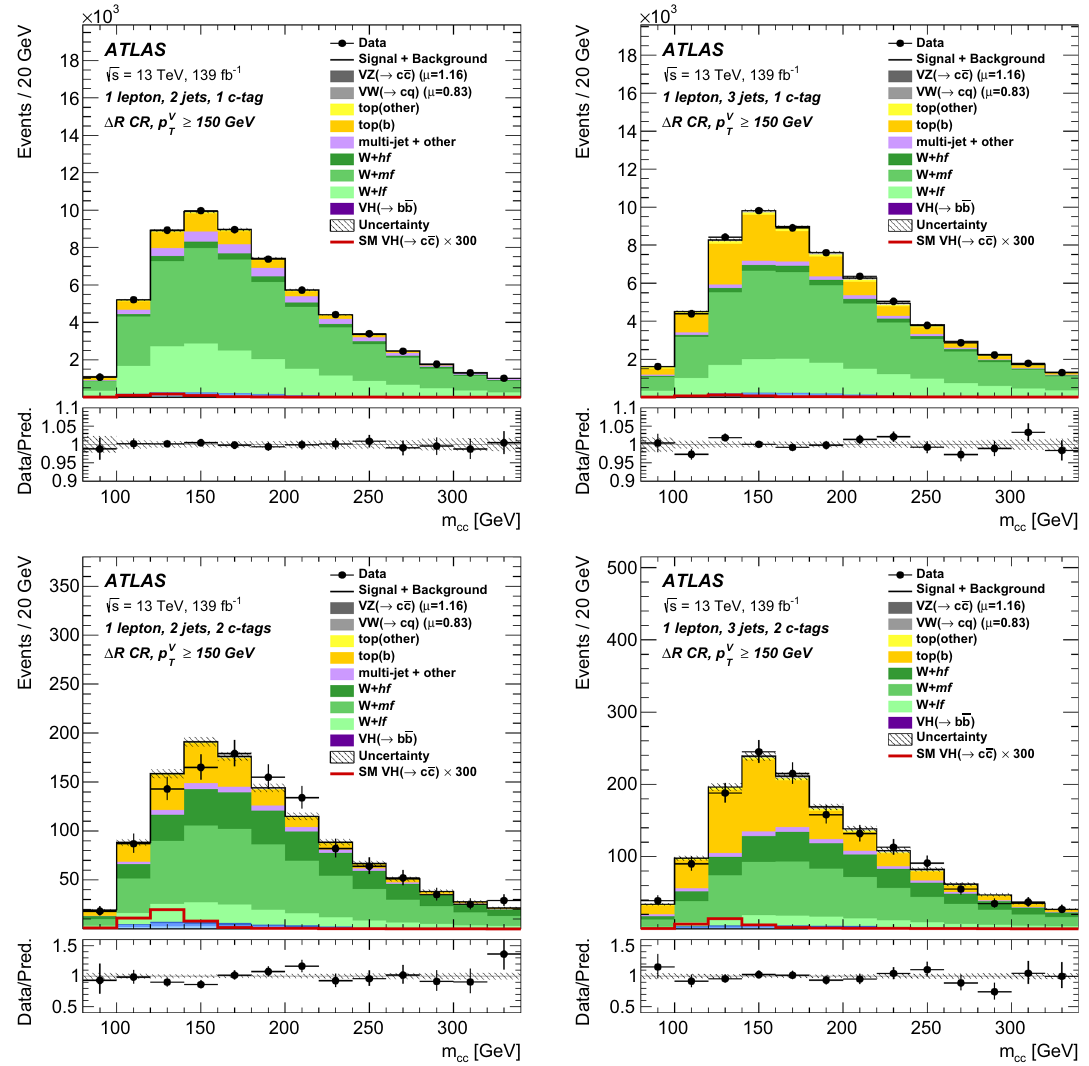
Fig. 12 Post-fit distributions of the four 1-lepton high- (cid:11) R control regions. The total signal-plus-background prediction is shown by the solid black line and includes the H → c ¯ c signal scaled to the best- fit value of μ VH ( c ¯ c ) = − 9. The H → c ¯ c signal is also shown as an